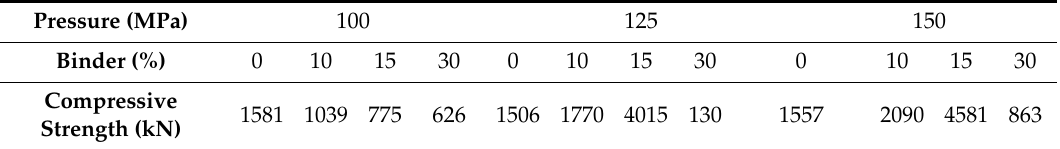
Table 1. Compressive strength of biomass briquettes produced at di ff erent pressure levels and di ff erent binder contents.